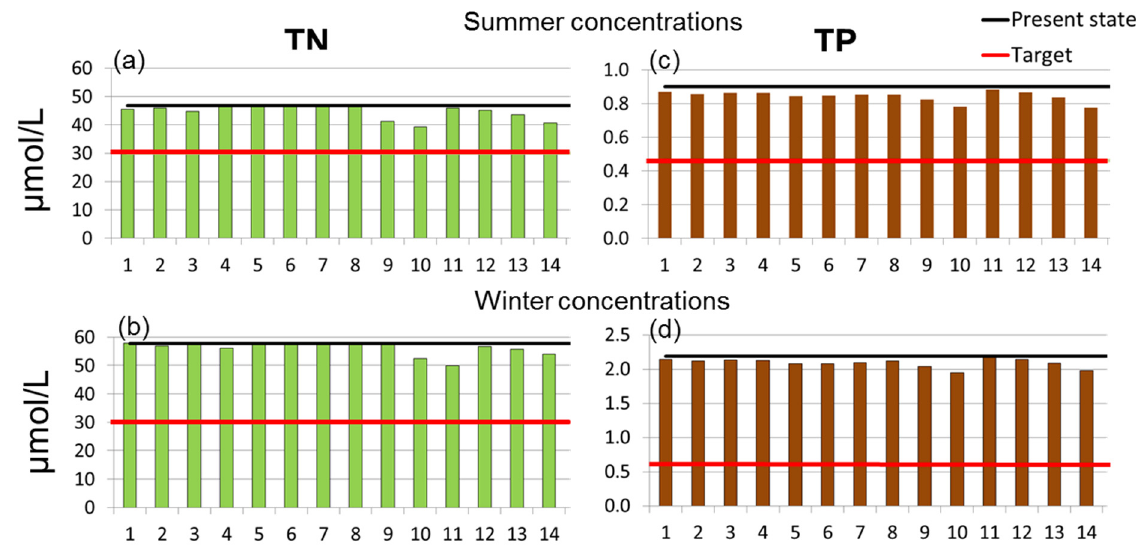
Figure 9. The effect of remedial measures on summer and winter concentrations of total N ( a , b ) and total P ( c , d ) in the surface water of Slätbaken Bay during summer (June to August) and winter (December to February). The x-axis corresponds to scenario No. 1–14 in Table 1. Horizontal lines indicate present conditions and the target for good ecological status according to the WFD.